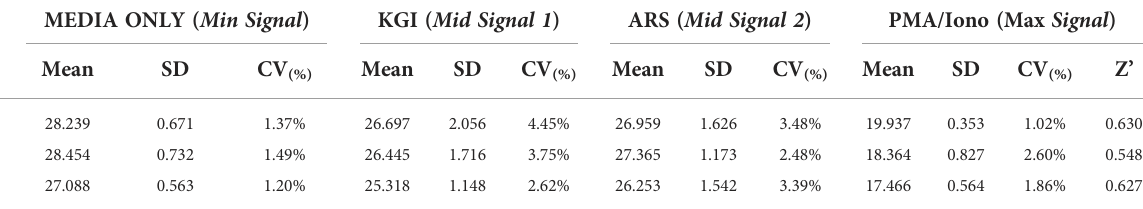
TABLE 1 Assay uniformity and quality